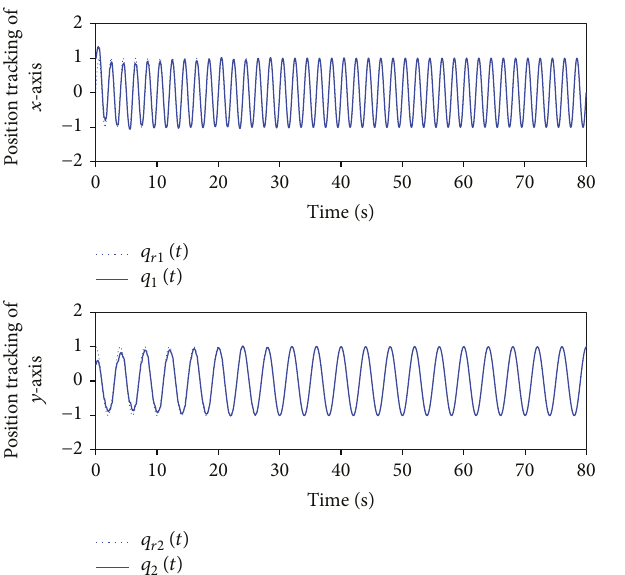
Figure 4: Tracking trajectory using ABFONTSMC-FNN.